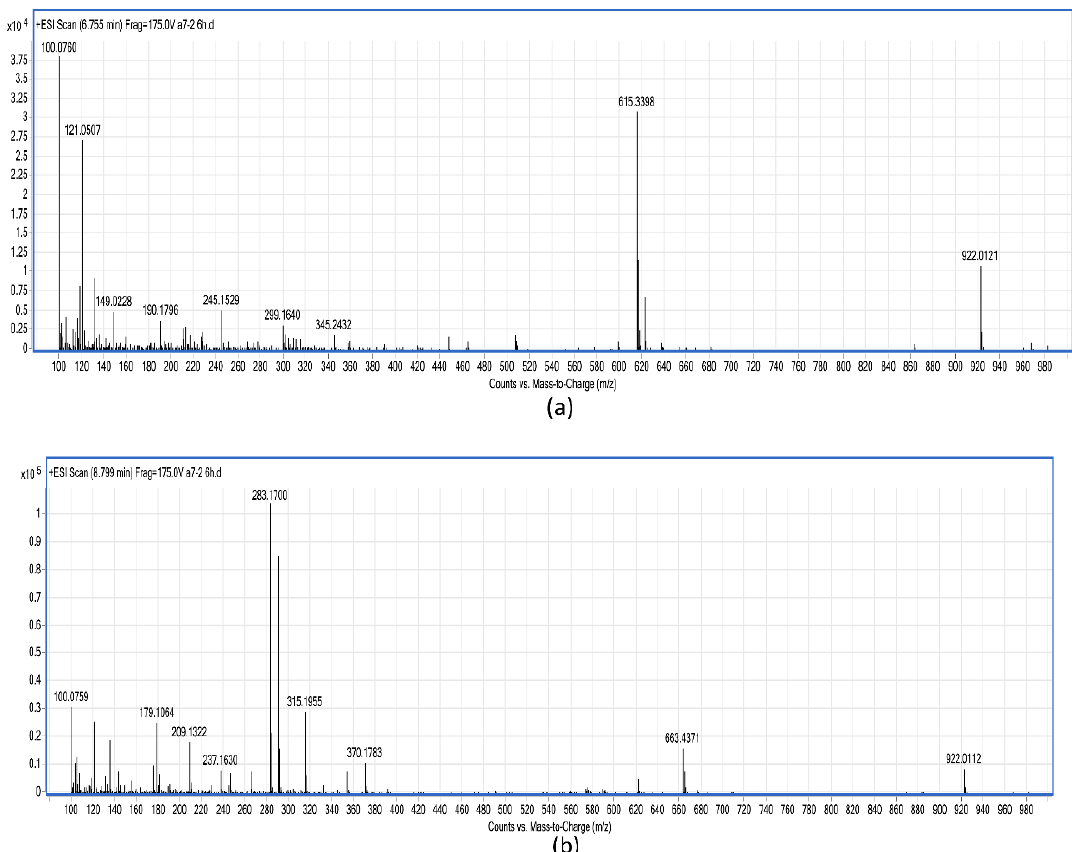
Figure 7. Electrospray ionization time-of-flight mass spectrometry (ESI-TOF-MS) spectrum of MC-LR degradation product. ( a ) MC-LR degradation product peak B with a molecular weight of 615.3398 ([M+H] + ). ( b ) MC-LR degradation product peak A with a molecular weight of 283.1700 ([M+H−NH 3 −MeOH] + ).